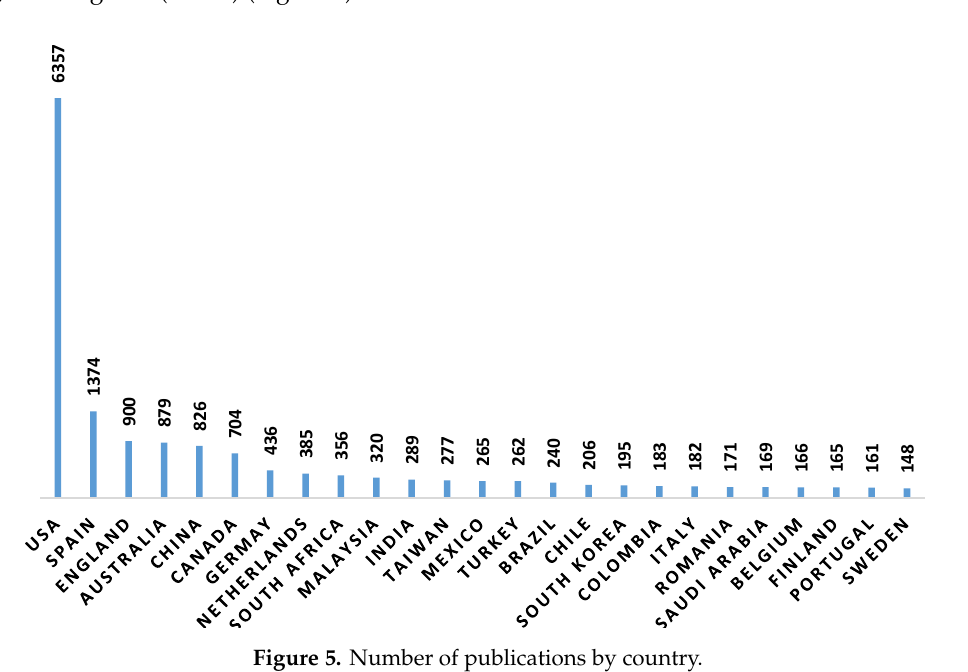
Figure 4. Top ten journals with the most publications.